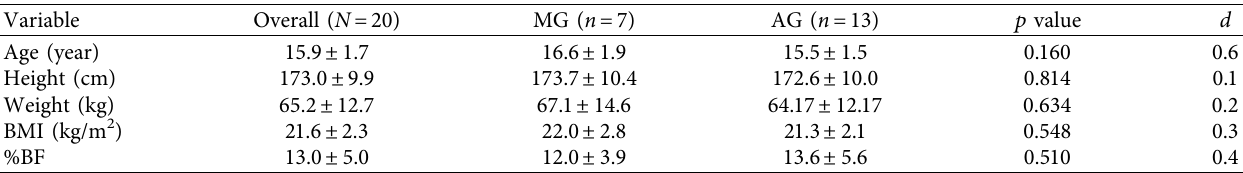
Table 1: Descriptive characteristics of participants disaggregated based on athletes considered as adapted to and maladapted to training. Data are presented as mean ±